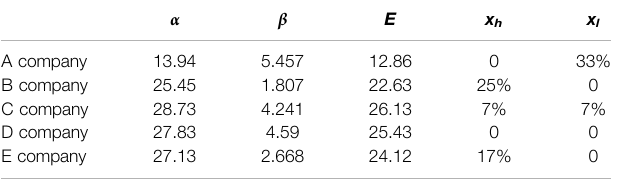
TABLE 3 | Corresponding parameters of equipment of each manufacturer.